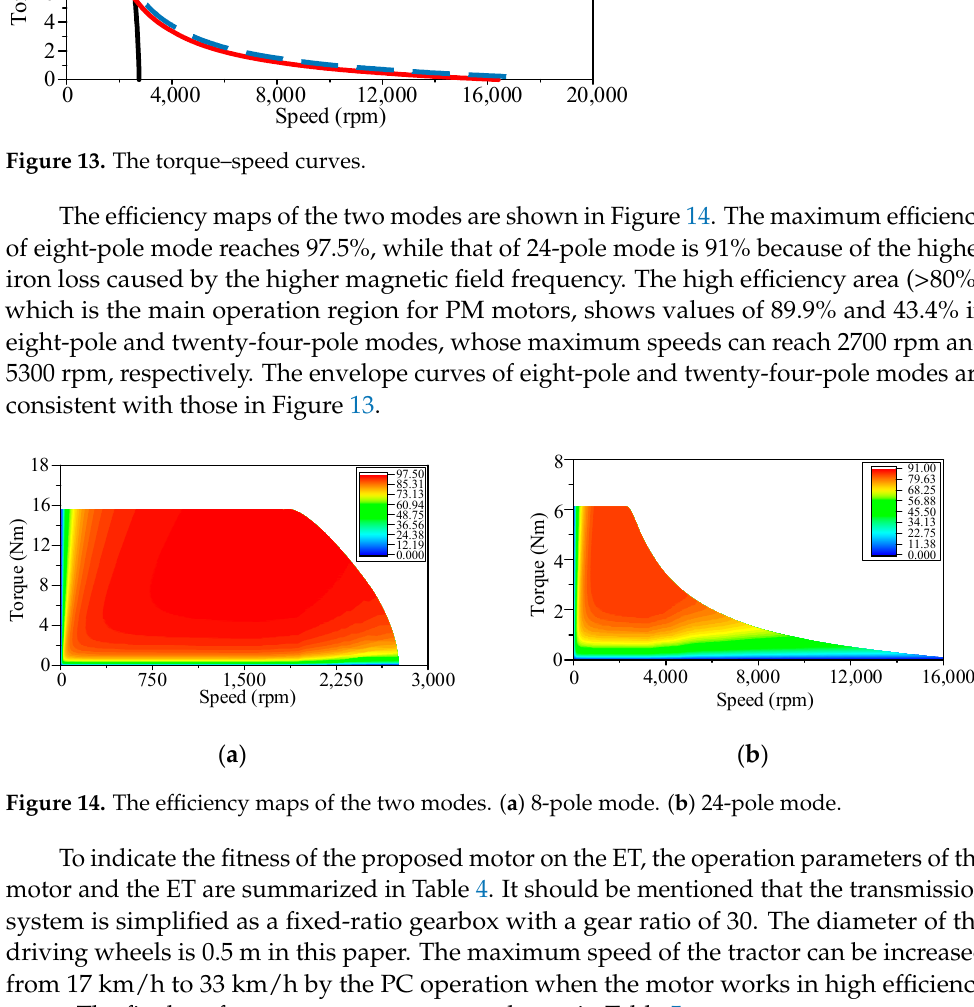
Table 4. Operation parameters of DHPCM-SPMPs and ET.